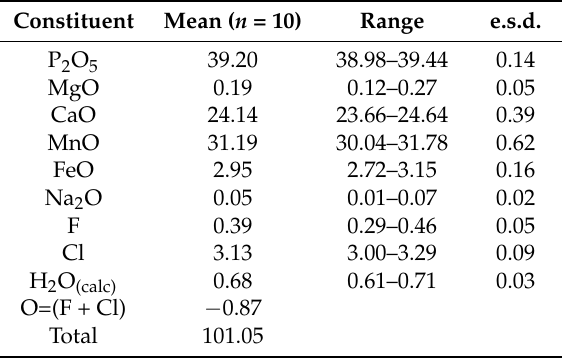
Table 1. Chemical composition of parafiunikite (in wt%).